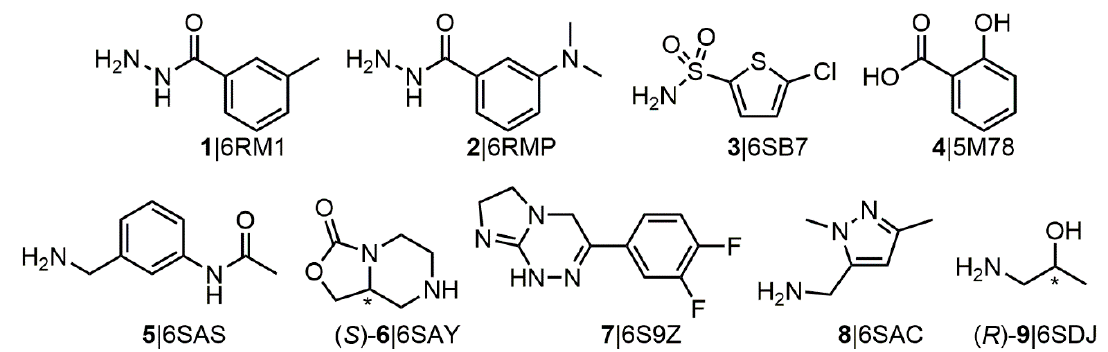
Figure 1. Fragment-sized molecules found in the hCAII crystal structure, comprising library entries 1 – 8 and the putative cryoprotectant 9 . PDB entry codes for the complexes with hCAII are given, as well as the stereochemical information for the bound enantiomers of compounds 6 and 9 ; * denotes the